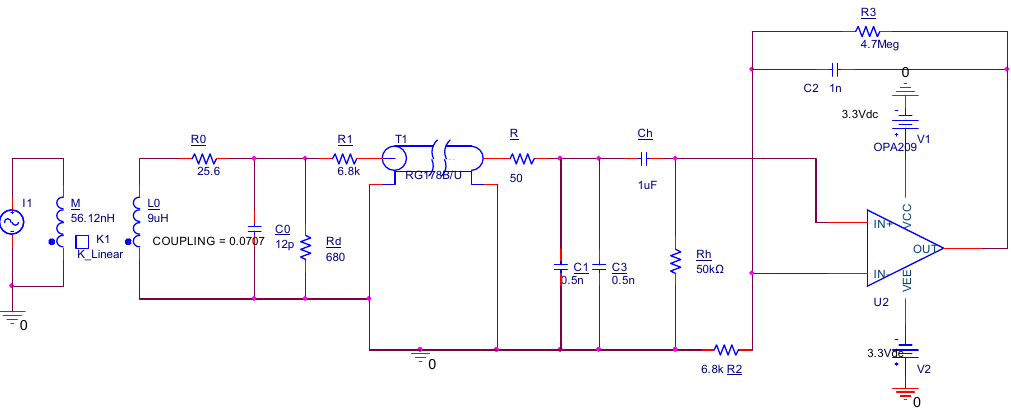
Figure 10. Improved integral circuit.